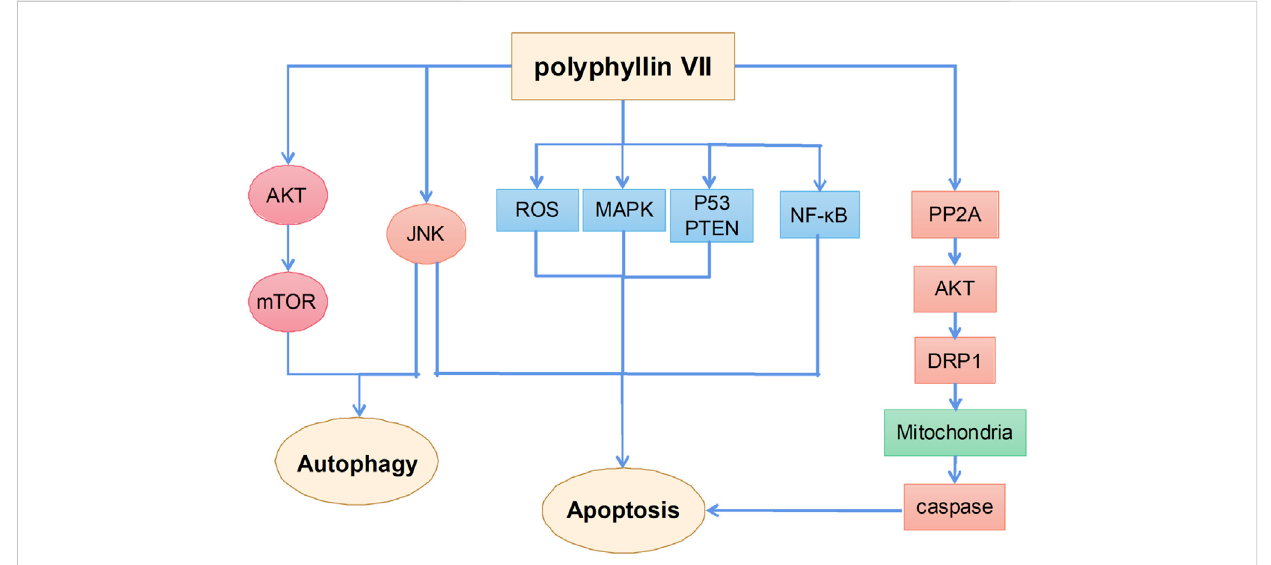
The primary mechanism for the anti-tumor effects of Polyphyllin